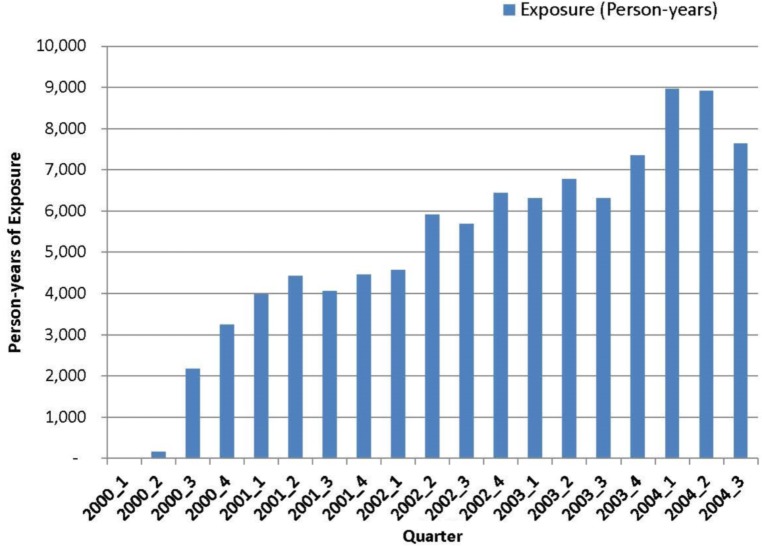
Rofecoxib exposure (person-years) cumulated over time in the EU-ADR database network.